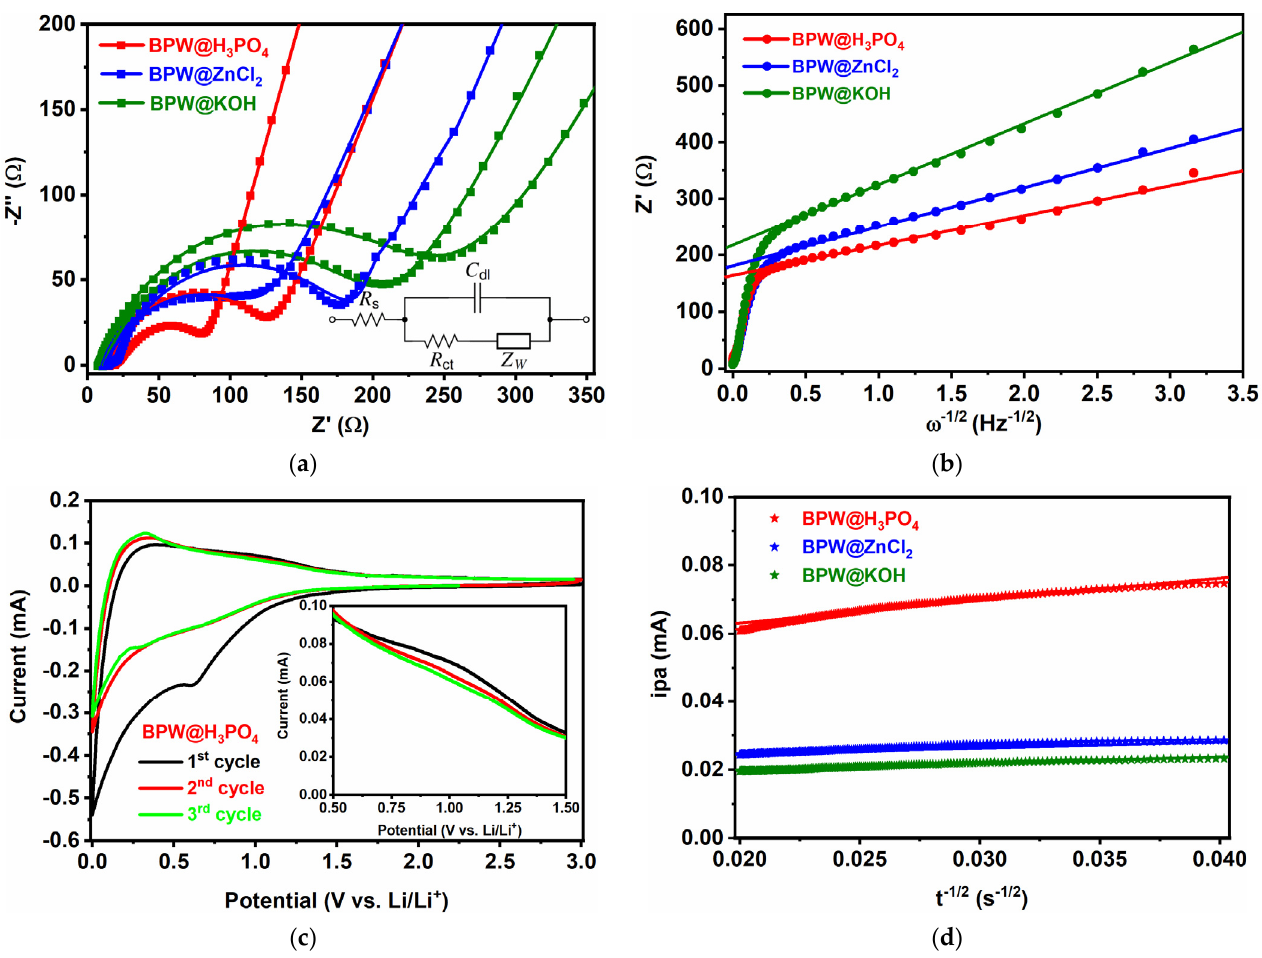
Figure 3. ( a ) Fitted Nyquist plots of electrodes before and after CV. (Inset) Equivalent circuit model used. ( b ) Linear fitting of Warburg impedance of electrodes. ( c ) CV curves recorded at 0.1 mV s − 1 of BPW@H 3 PO 4 electrode. (Inset) Zoom of ‘‘hump’’ region. ( d ) Fitted response of current versus t − 1/2 for electrodes with the half discharge degree under the ‘‘hump’’ potential.